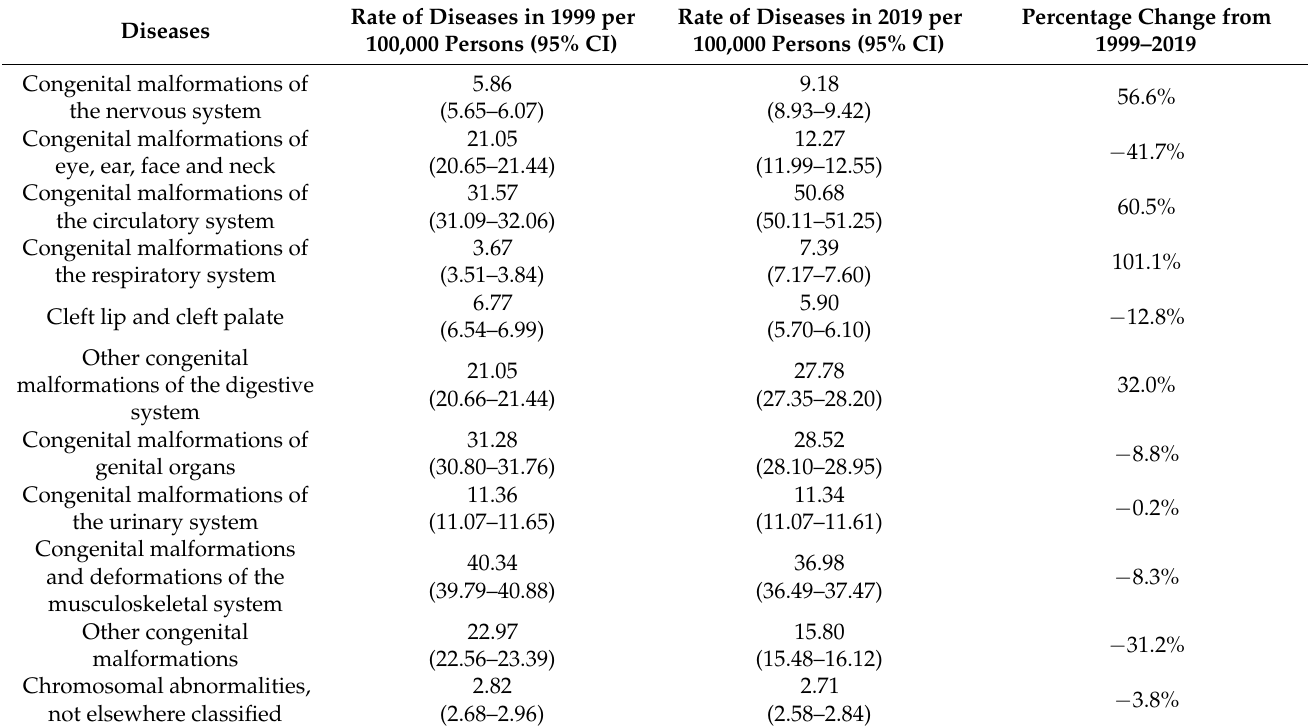
Table 2. Percentage change in the hospital admission rates for congenital malformations, deformations and chromosomal abnormalities from 1999–2019 in England and